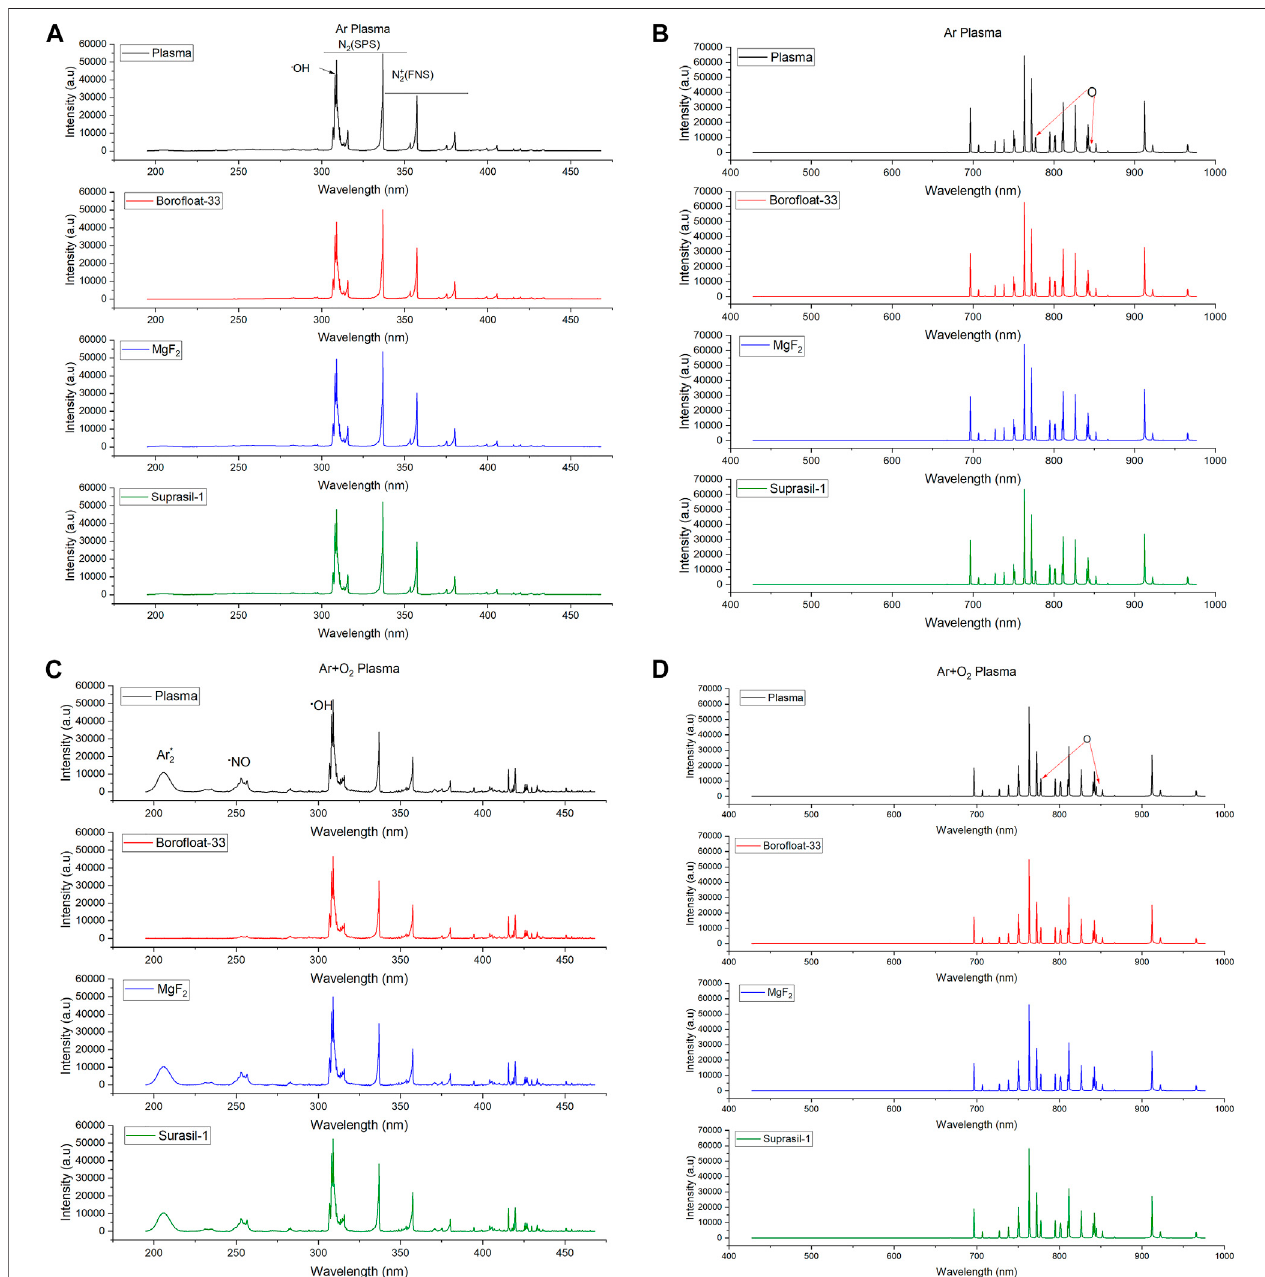
FIGURE3 | OESspectra registered at 9 mm distance from jet nozzle in therange 195 – 465 nm (UV range, (A and C) and 430 – 980 nm (VIS/NIR range, (B and D) . (A and B) : kINPen09, 3 slm Ar, (C and D) : kINPen09/3slm Ar + 0.5% oxygen. Free plasma jet, and radiation fi ltered through MgF 2 (transparent > 125 nm), Suprasil (quartz based, > 195 nm), and Boro fl oat glass ( > 300 nm) were compared (see legend in spectra). Due to limitations in setup (no measurements < 195 nm), only slight changes between 200 and 300 nm were observed. The VIS/NIR region remained unchanged by the different windows except for a minor reduction in intensity.